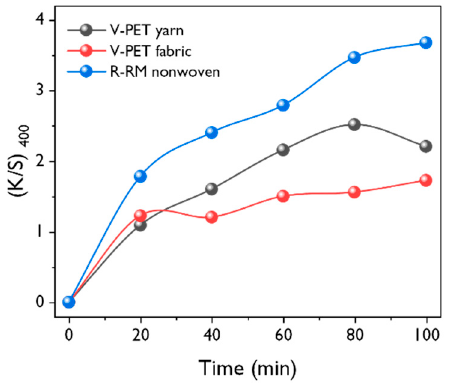
Figure 7. E ff ect of the dyeing time on the K / S value measured at 400 nm (dye concentration = 10 %owf; Figure 7. Effect of the dyeing time on the K/S value measured at 400 nm (dye concentration = 10 %owf; dyeing temperature = 130 ◦ C; liquor ratio = dyeing temperature = 130 °C ; liquor ratio = 1:50).